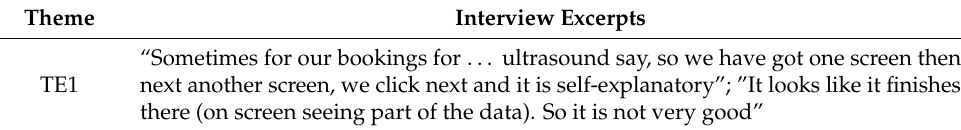
Table 4. Data excerpts supporting system usability/ease-of-use